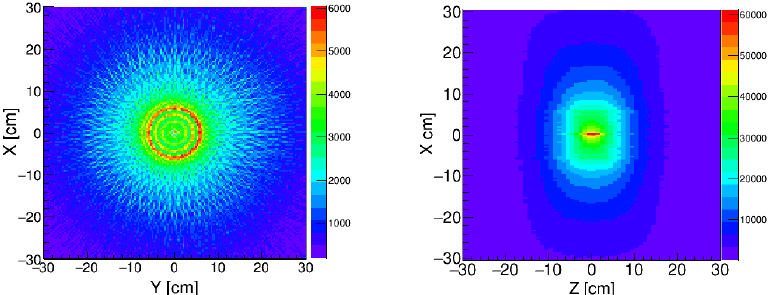
Figure 1. Tomographic image of the annihilation target cylinder obtained using Ps → 2 γ annihila- tions used as a benchmark for the 3 annihilation reconstruction studies. In the transverse view (left) the | z | > 3 cm region was excluded to avoid high intensity of annihilations occurring directly in the β + source, visible in the side view